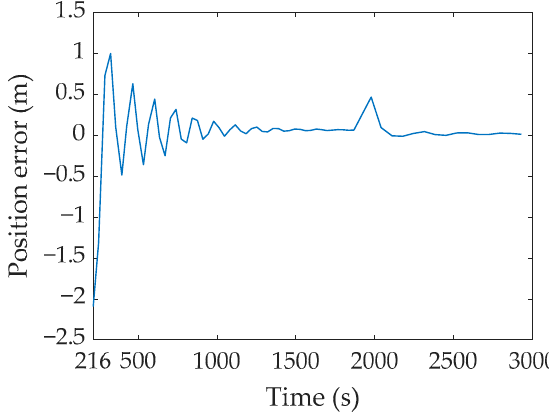
Figure 15. Cross-track position error for the half-moon shape.